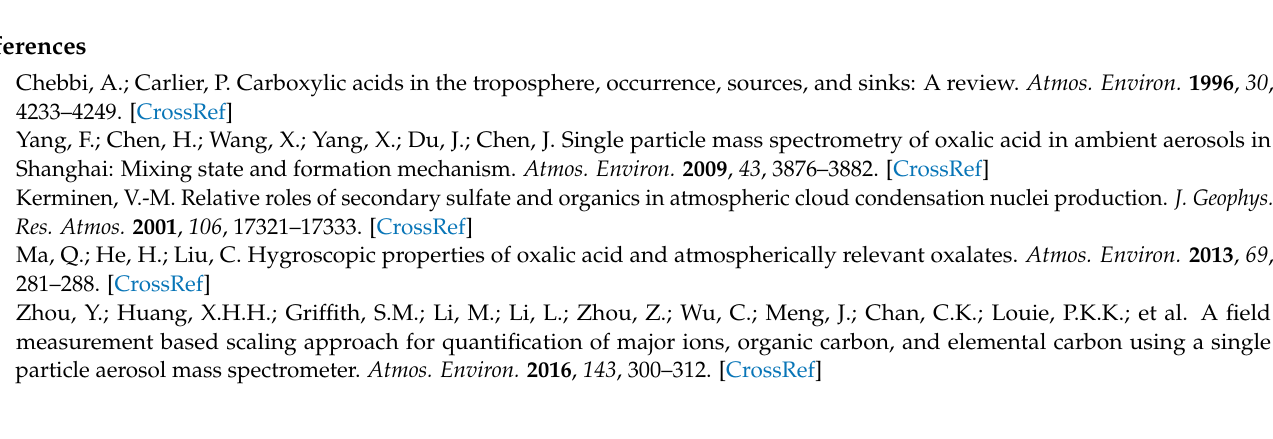
the Art-2a clustering algorithm; Figure S3: Time trends of the major types of oxalate-containing particles, plotted by ratio of oxalate group particle number to total particle number at (a) LQH and (b) OUC; Figure S4: Number fraction of selected ion markers associated with single-particle types at (a) LQH and (b) OUC; Figure S5: Diurnal variations of oxalate ( m / z − 89) PA (a), and RPA (b) in Fe-rich particles and oxalate ( m / z − 89) PA (c), and RPA (d) in BB-Fe particles and oxalate ( m / z − 89) PA (e), and RPA (f) in BB-noFe particles; Figure S6: Average decay estimation of oxalate intensity in different oxalate-Fe complexes. (Plotted by particle RPA of m / z − 89; box and error bars represent the 10th, 25th, 50th 75th, and 90th percentiles; and the red diamond represents the mean); Figure S7: Average diurnal variation in classified oxalate groups (contribution of relative particle number from each classified group to that of the total oxalate particles) at (a) LQH and (b) OUC; Figure S8: Average diurnal variation in classified oxalate groups (contribution of m / z − 89 RPA from each classified group to that of the total oxalate particles) at (a) LQH and (b)